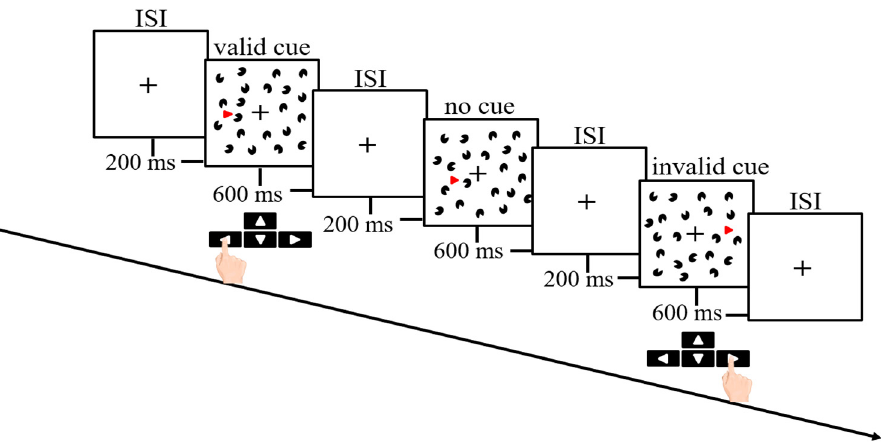
Figure 2. Illustration of the Kanizsa test used in the present study. The target triangle either appeared inside the Kanizsa triangle (valid cue), contralateral to the Kanizsa triangle (invalid cue), or in a cue without the Kanizsa triangle (no cue). The participants were instructed to indicate the direction of the target triangle (right or left). ISI: Interstimulus interval.